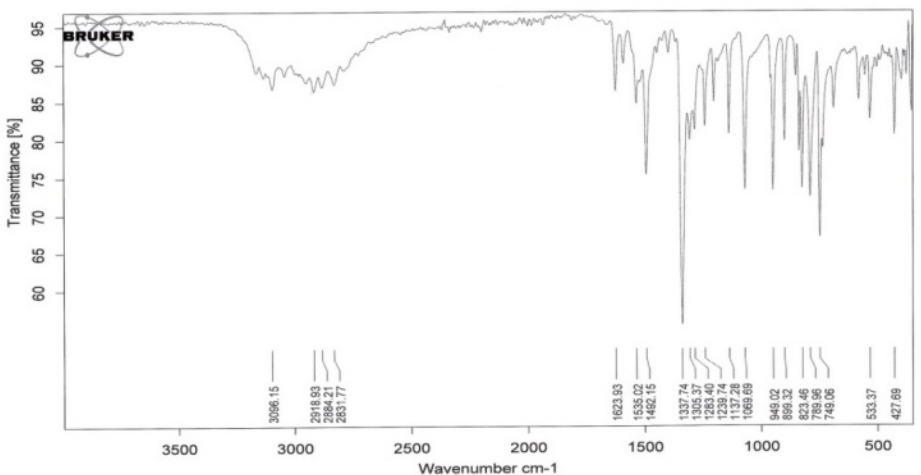
Figure 1. The FT-IR spectra of 1-(5 ′ -nitrobenzimidazole-2 ′ -yl-sulphonyl-acetyl)-4-(p-methoxyphenyl)-thiosemicarbazide ( VII ).